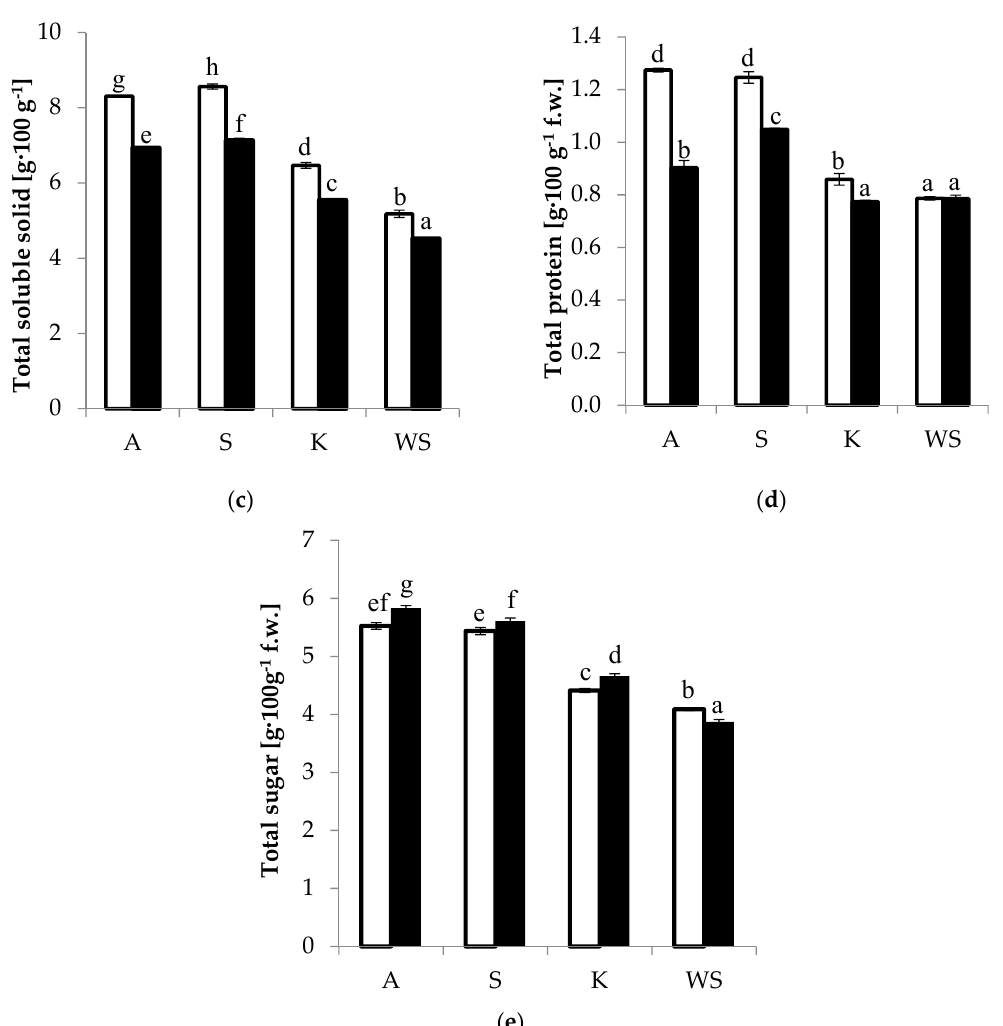
Figure 3. Selected physicochemical parameters of carrot juices. ( a ) Dry matter; ( b ) pH; ( c ) Total soluble solid; ( d ) Total protein; ( e ) Total sugar. White bars, CJ and black bars, BCJ. Various types: A, Askona F1; S, Samba F1; K, Kazan F1; WS, White Satin. Mean ± SE, the same letters set no differences at p < 0.05.